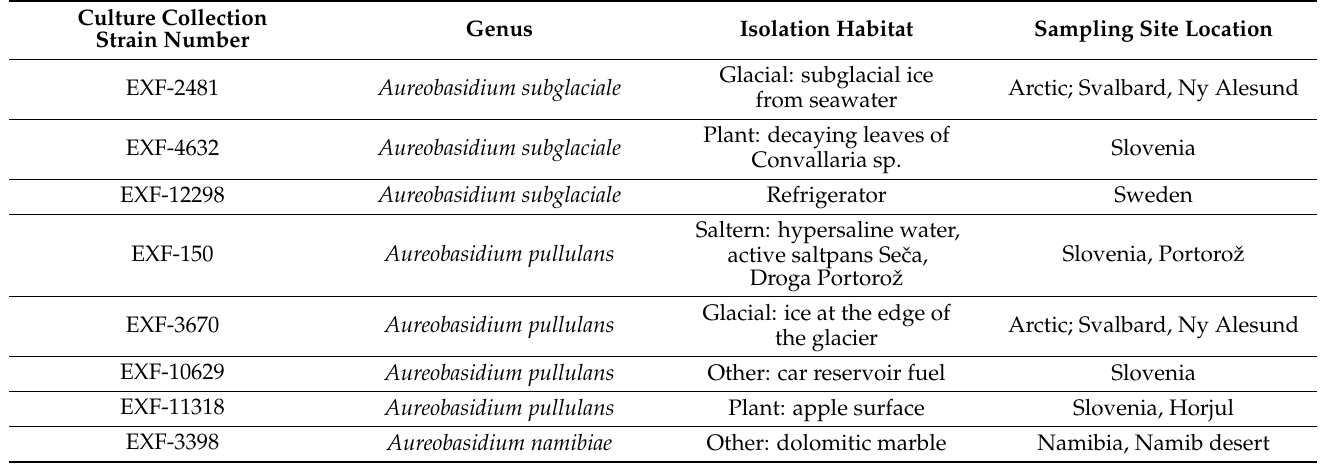
Table 2. List of Aureobasidium spp. strains used in this